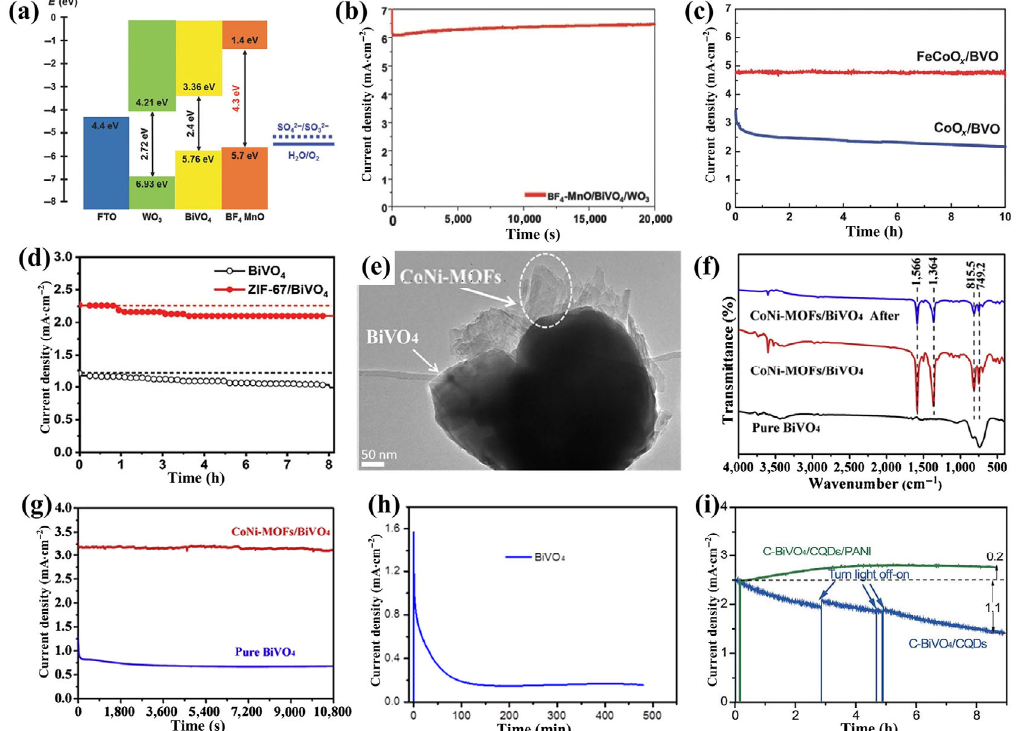
Figure 7 (a) Flat-band structures and (b) I – T curve of BF 4 -treated MnO/BiVO 4 /WO 3 . Reproduced with permission from Ref. [122], © Lee, M. G. et al. 2018. (c) I – T curve of CoO x /BVO and FeCoO x /BVO at 1.23 V vs. RHE. Reproduced with permission from Ref. [72], © WILEY-VCH Verlag GmbH & Co. KGaA, Weinheim 2018. (d) Plot of photocurrent versus time under simulated sunlight exposure. Reproduced with permission from Ref. [126], © Wiley-VCH GmbH 2020. (e) TEM image of CoNi-MOF/BiVO 4 and (f) FTIR spectra of BiVO 4 , CoNi-MOF, and CoNi-MOF/BiVO 4 . (g) I – T curves measured at 1.23 V vs. RHE for CoNi-MOF/BiVO 4 and pristine BiVO 4 . Reproduced with permission from Ref. [130], © Elsevier B.V. 2020. (h) I – T curves of the BiVO 4 samples in 0.5 M borate buffer (pH = 9.5) electrolyte solution at a constant potential of 1.0 V vs. RHE under standard sunlight. (i) I – T curves of